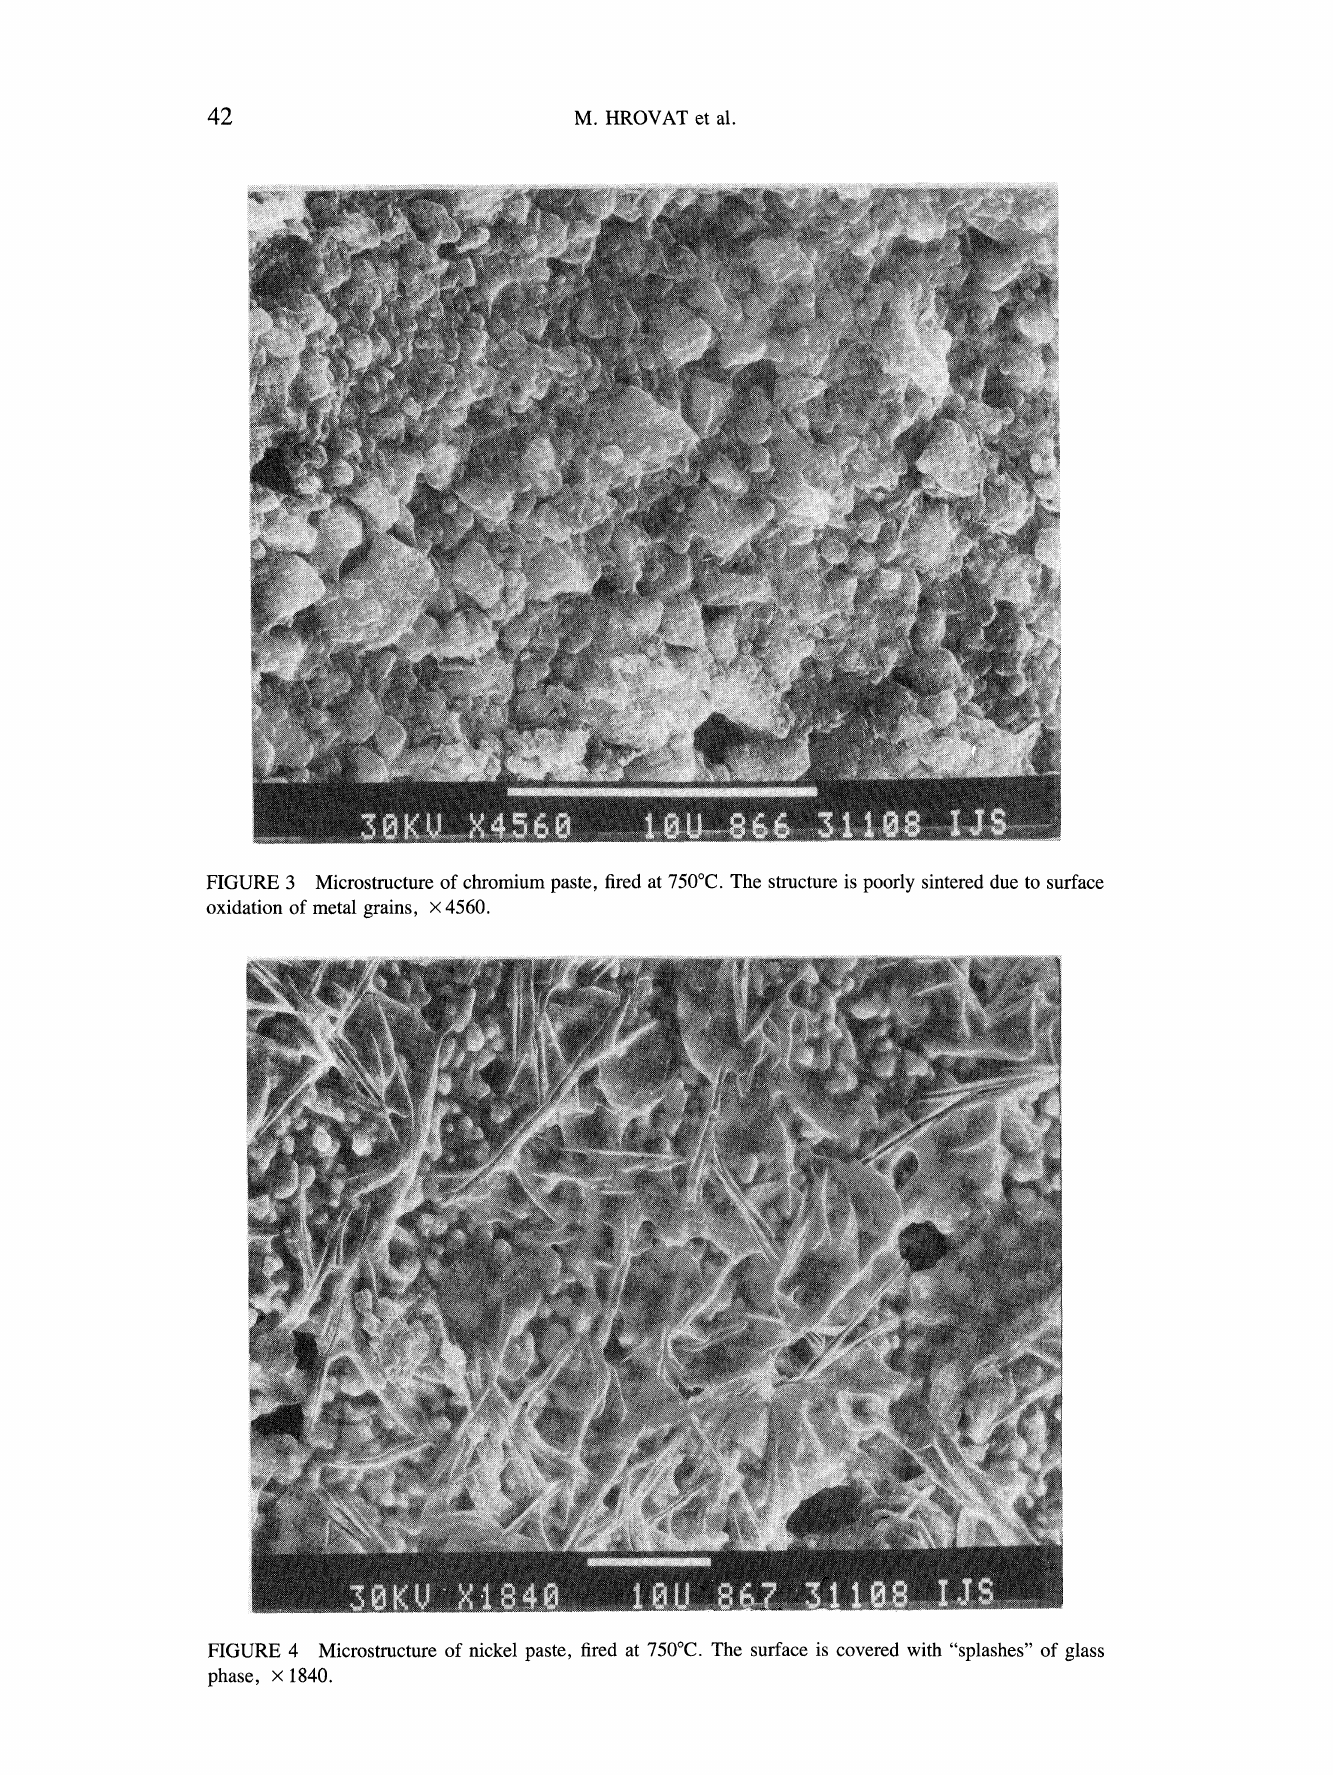
FIGURE 4 Microstructure of nickel paste, fired at 750C. The surface is covered with "splashes" of glass phase, x